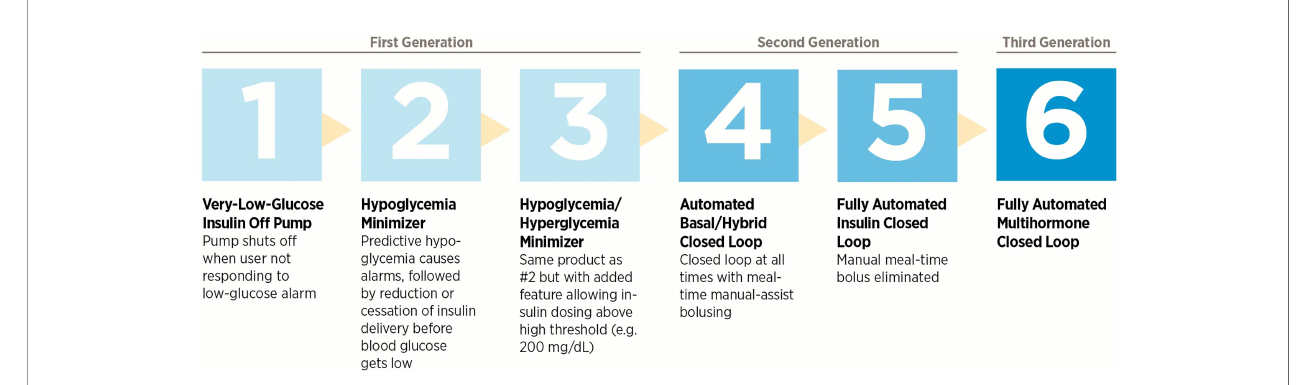
FIGURE 2 | The six categories of closed-loop systems as de fi ned by